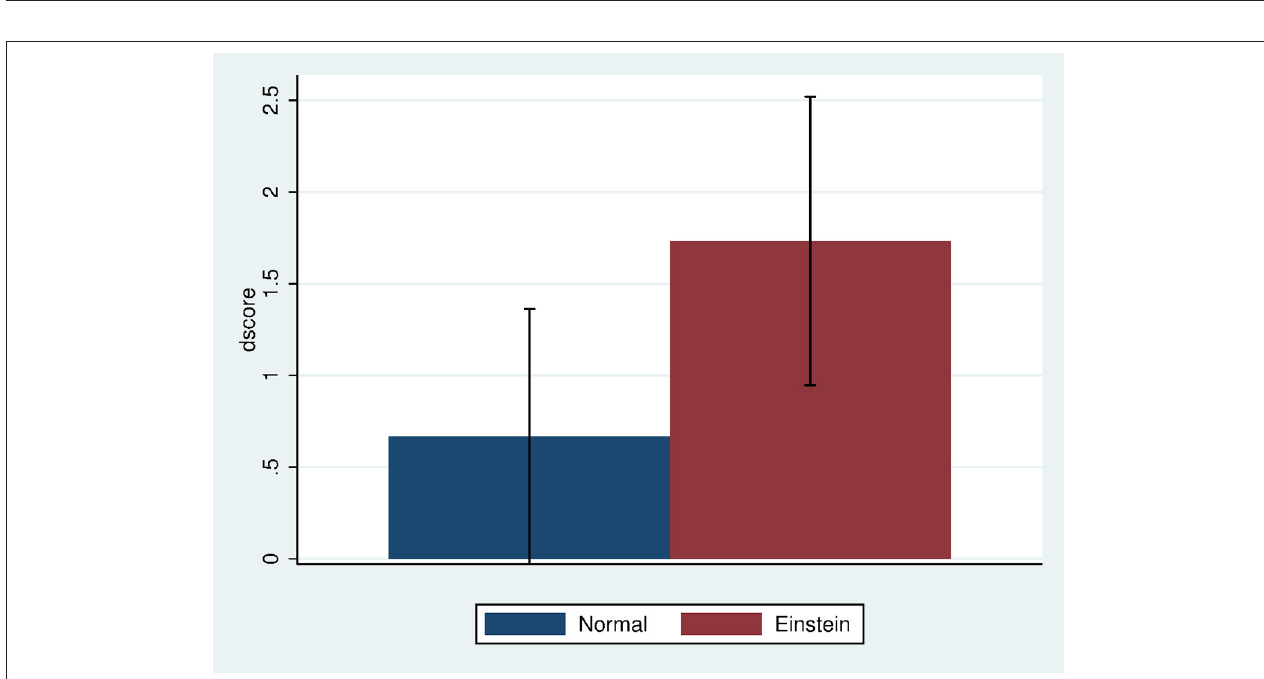
FIGURE 3 | Bar chart showing mean and standard error of dscore by Body.